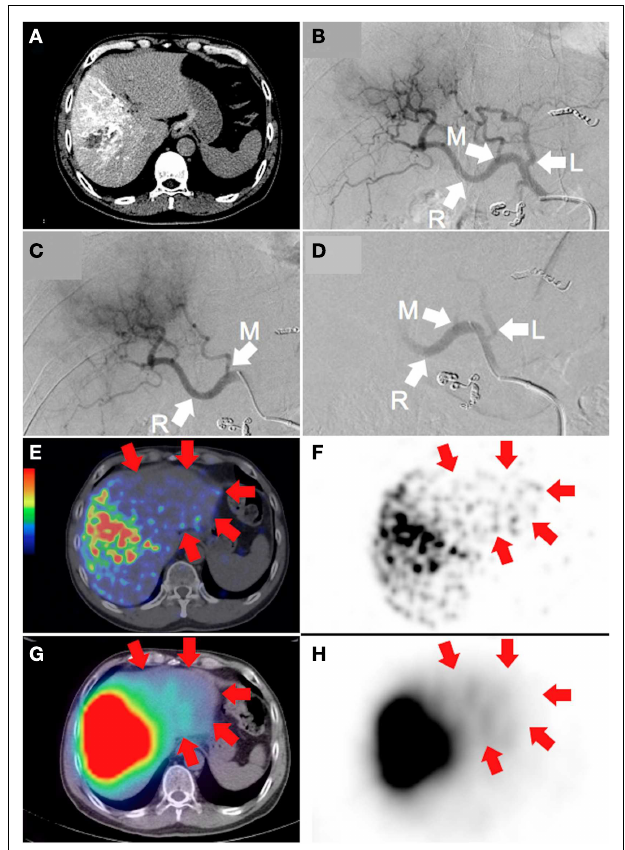
FIGURE 1 | Large hepatocellular carcinoma of the right lobe (actual tumor not well depicted) . (A) Catheter-directed CT angiogram of the right hepatic artery, proximal to the origin of the middle hepatic artery, delineates the target arterial territory. (B) Digital subtraction angiography (DSA) of the proper hepatic artery demonstrates the hepatic arterial tree.The liver is supplied by the left hepatic artery (“L”; branch of the common hepatic artery), middle hepatic artery (“M”; branch of the right hepatic artery) and right hepatic artery (“R”; continuation of the common hepatic artery). Prophylactic coil embolization of the gastroduodenal, right gastric, and accessory left gastric arteries were performed. (C) DSA of the target arterial tree with the catheter tip in the right hepatic artery, proximal to the origin of the middle hepatic artery, immediately prior to RE. (D) Moderate vascular stasis and contrast reflux into the left and proper hepatic arteries is seen on DSA immediately after RE, with no change in catheter tip position. (E,F) 90 Y PET/CT depicts in high resolution, non-target activity in a non-random distribution conforming to the anatomy of the untargeted left liver lobe (arrows). (G,H) 90 Y bremsstrahlung SPECT/CT shows concordant but subtle diffuse non-target activity in the untargeted left liver lobe (arrows).